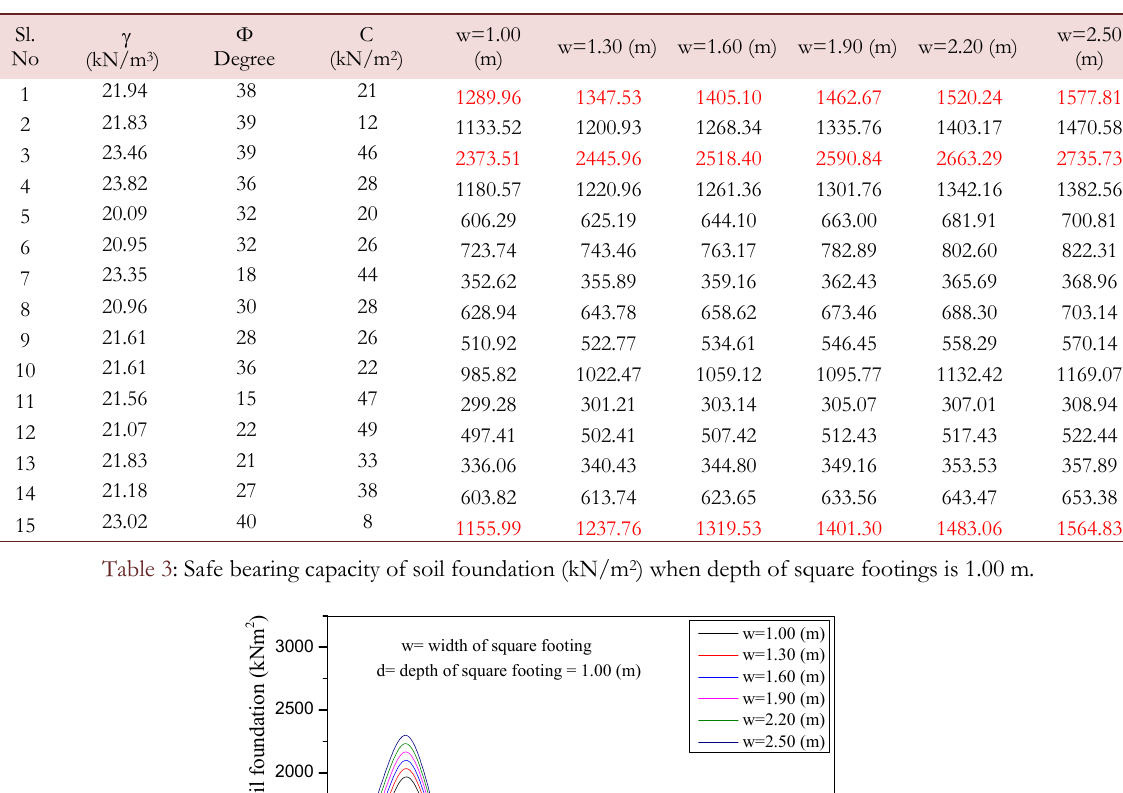
Figure 1: Safe bearing capacity of soil foundation (kN/m 2 ) Vs the mixed soil type.